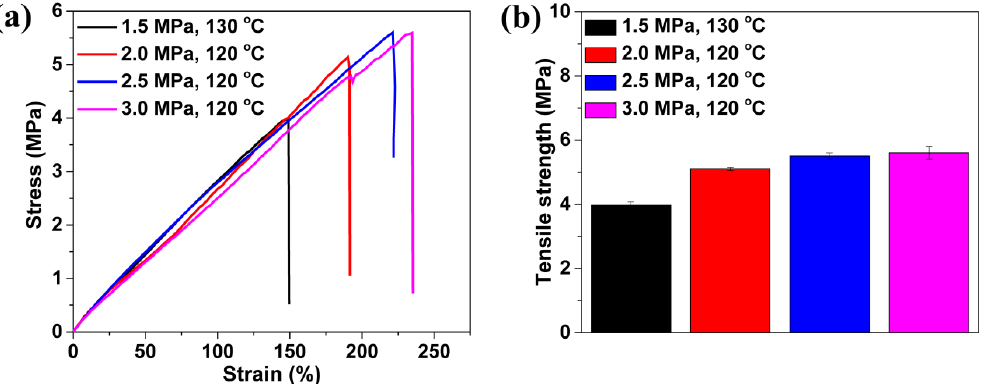
Figure 9. Tensile performance of TPU perforated membranes saturated and foamed under different pressures and temperatures. ( a ) typical stress-strain curves and ( b ) the tensile strength.